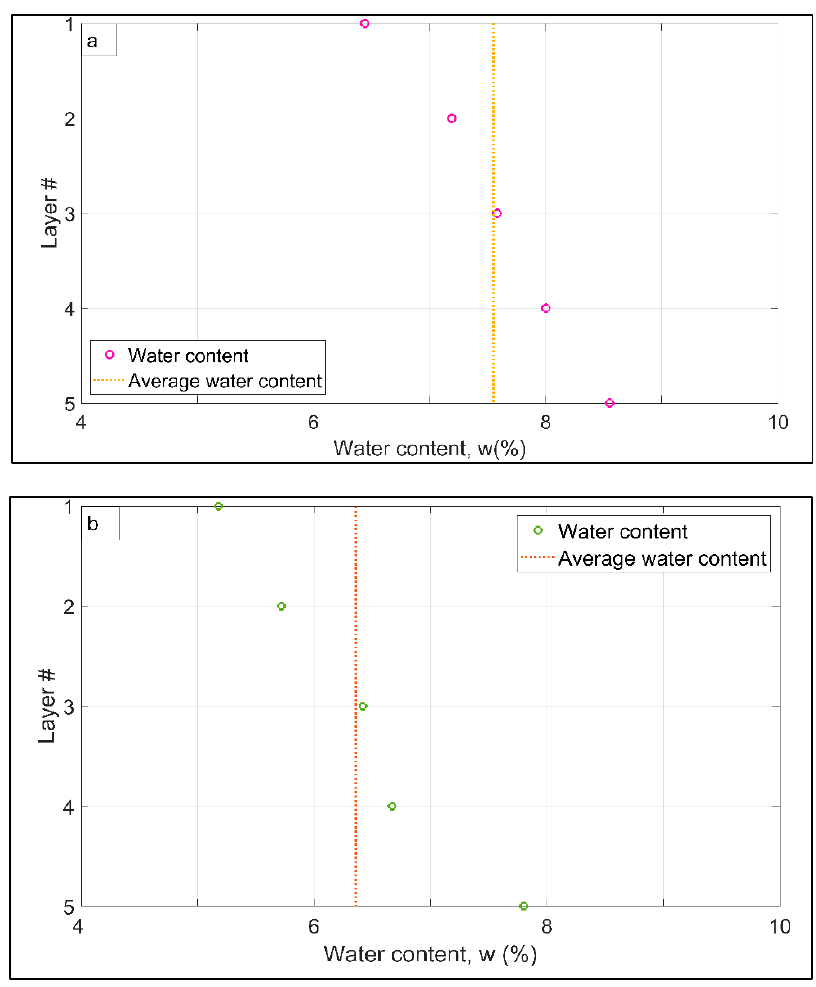
Figure 3. Water distribution measured over the length of a coarser sand specimen ( a ) Just after compaction, and ( b ) after complete test on hydrate-bearing sand.